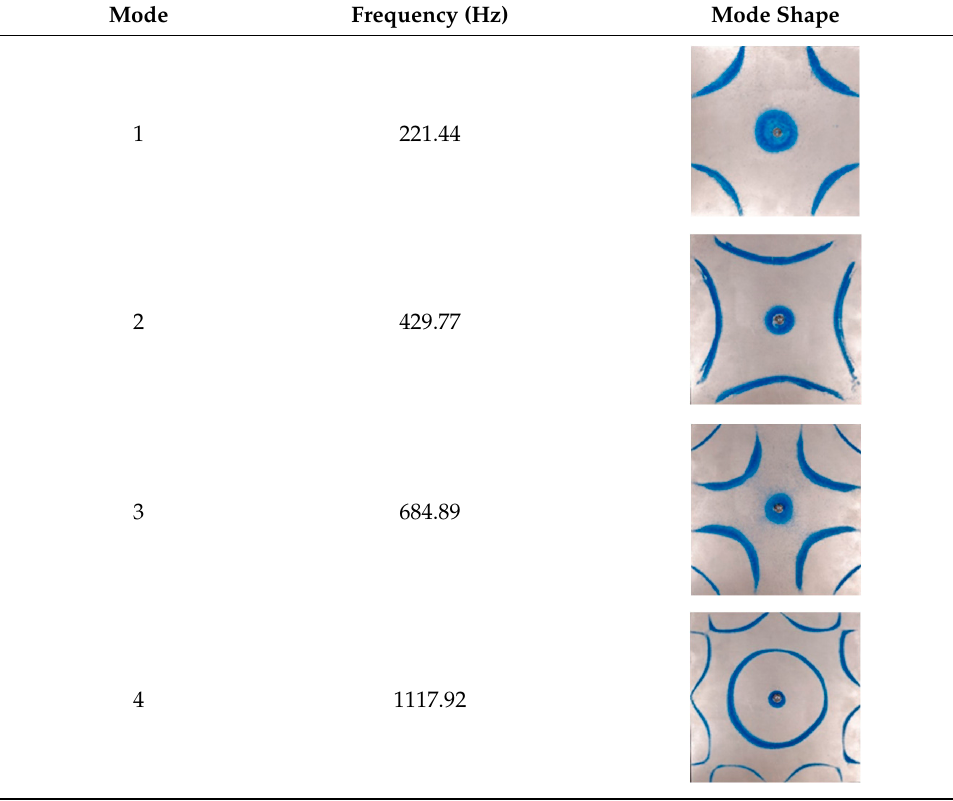
Table 2. Experimental natural frequencies and mode shapes.